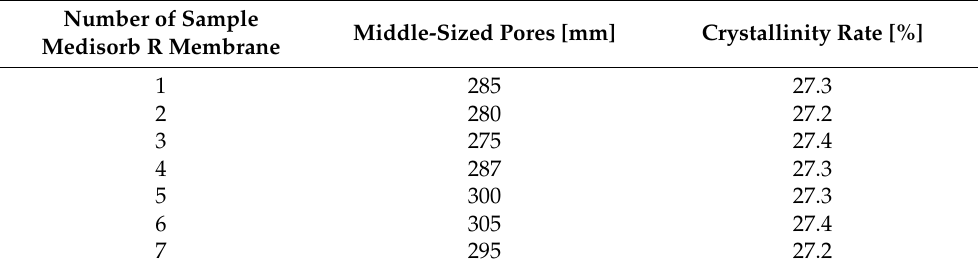
Table 7. The results of middle-sized pore measurements for the series of materials manufactured on an industrial scale.